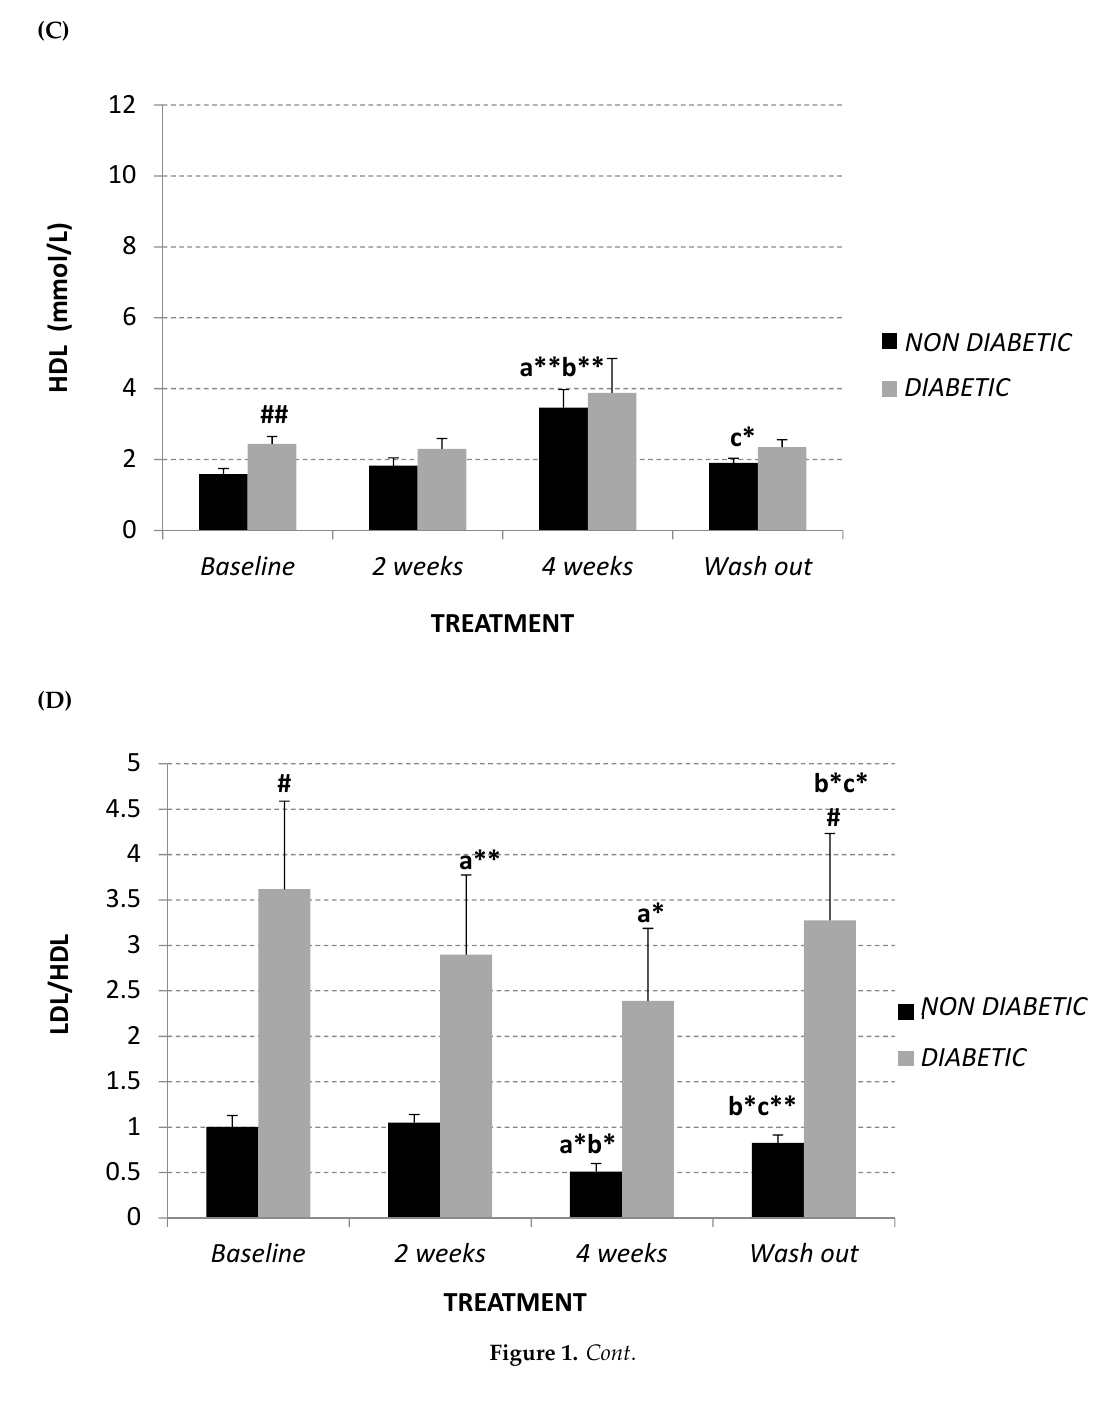
Figure 1. Cont Figure 1. Cont .